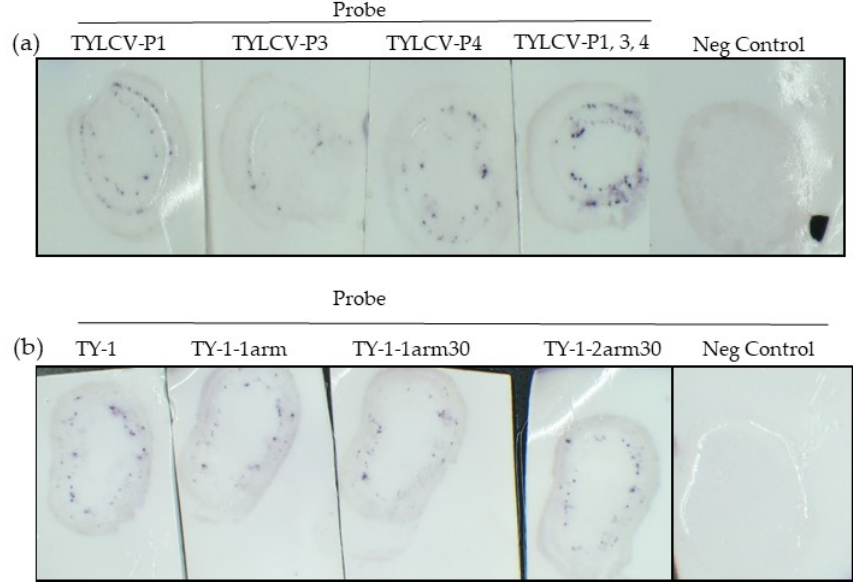
Figure 3. The various TYLCV probes. ( a ) TYLCV positive blots were probed with TYLCV-P1, -P3, or P4 or all three probes together, TYLCV-P1, -P3, and-P4. The negative control blot was incubated with all three probes. ( b ) Positive TYLCV blots were probed with TYLCV-P1, TY-1-1arm, TY-1- 1arm30, and TY-1-2arm30. The negative control blot shown was probed with TYLCV-P1. The other negative control blots appeared the same (not shown). All blots were probed at 55 °C, followed by incubation at 37 °C with the biotin hairpins Hpin-B1-1T and